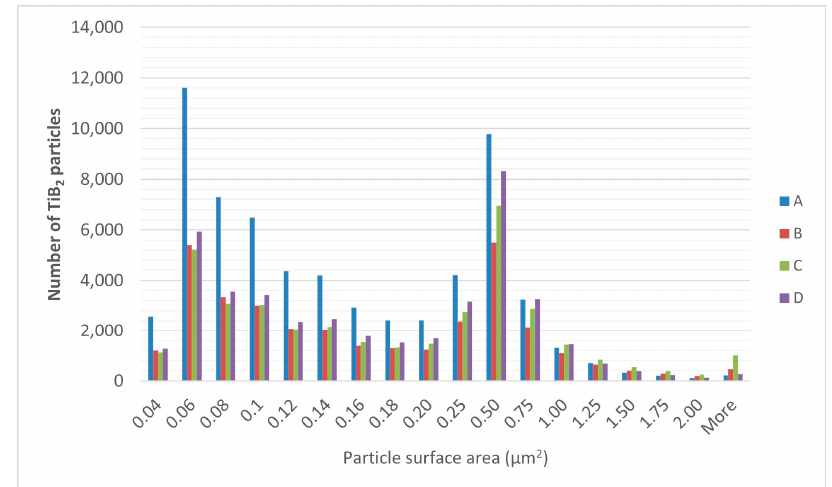
Figure 5. TiB 2 particle size distribution in various grain refiners.